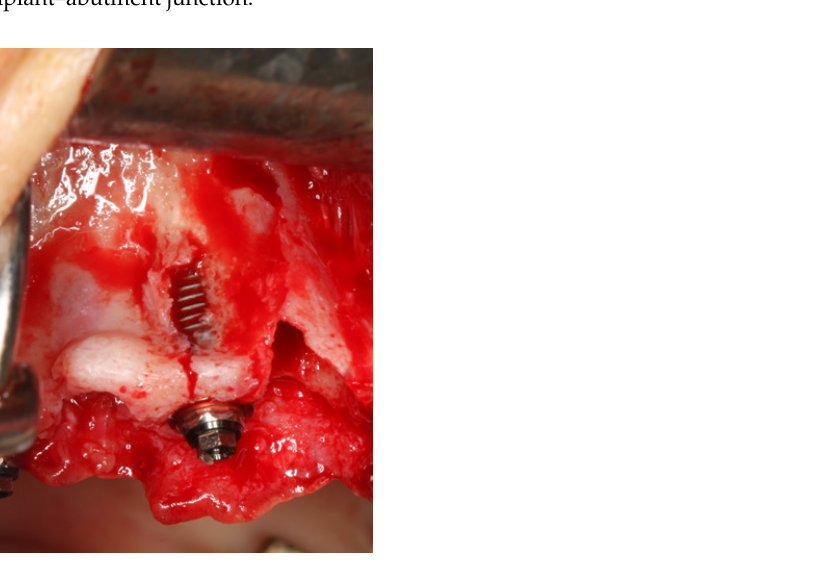
Figure 1. Intraoral photograph illustrating dehiscence: the absence of alveolar bone on the buccal or palatine/lingual aspects, leaving an oval-shaped defect and implant exposure apically from the implant–abutment junction.